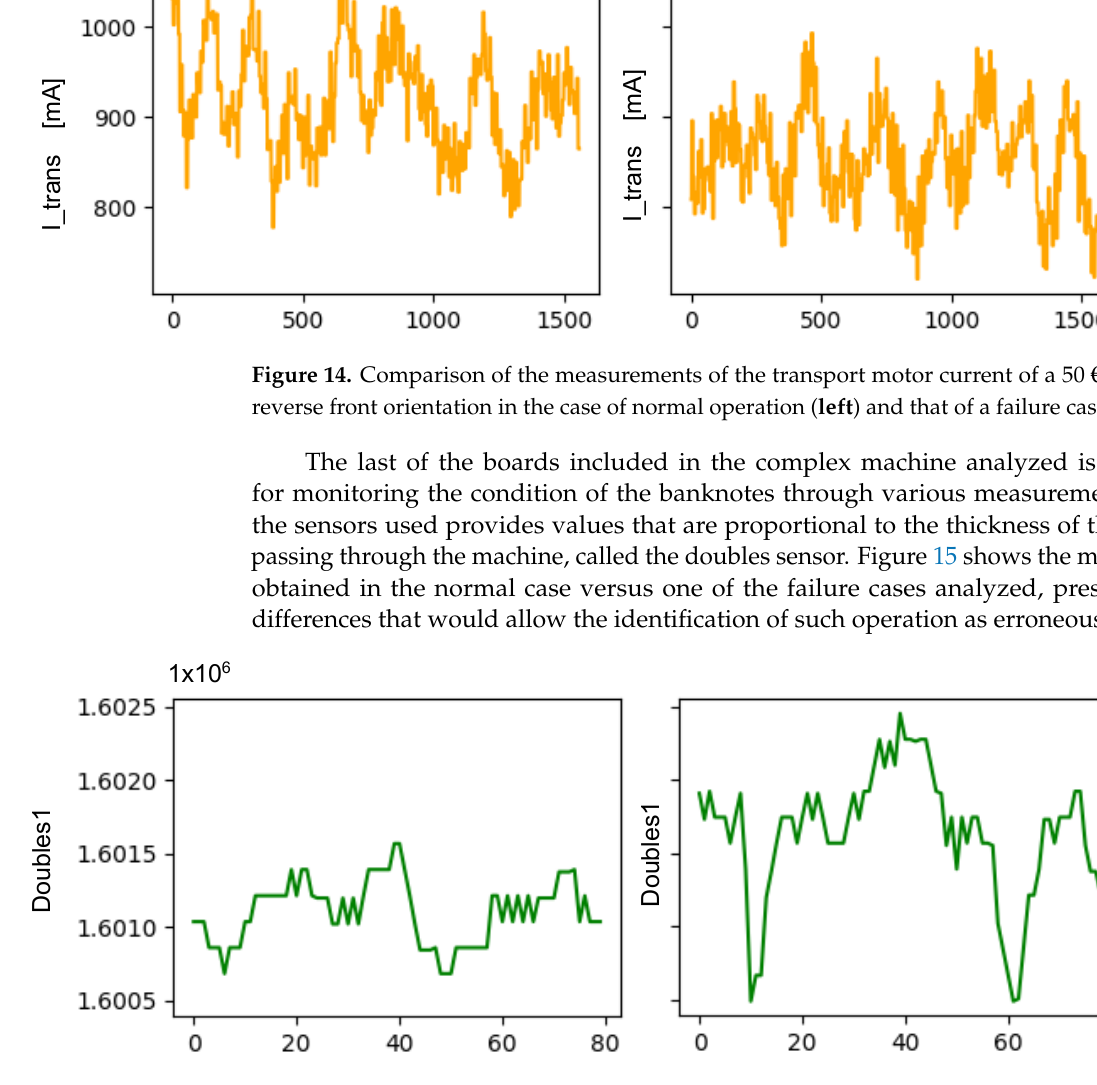
Figure 15. Comparison of the measurements of the double sensor 1 of a 20€ banknote on back orientation in the case of normal operation ( left ) and one case of failure ( right ).